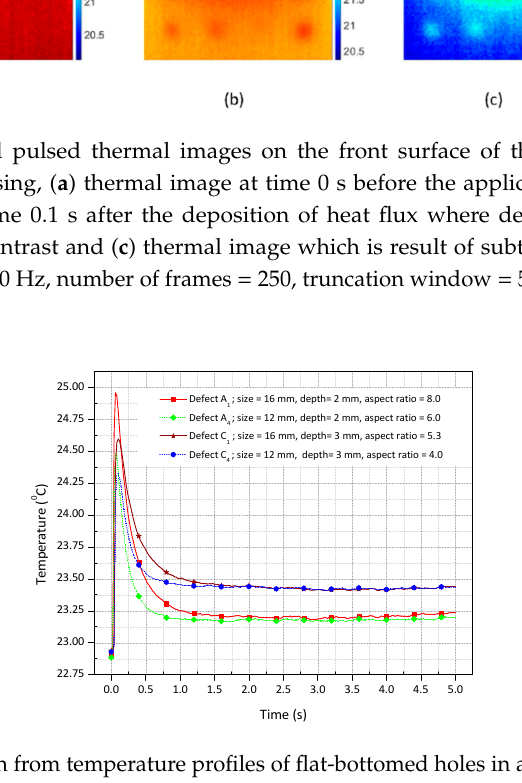
Figure 6. Defect detection from temperature profiles of flat-bottomed holes in a steel plate subjected to pulse heating [Frequency = 50 Hz, number of frames = 250, truncation window = 5 s].